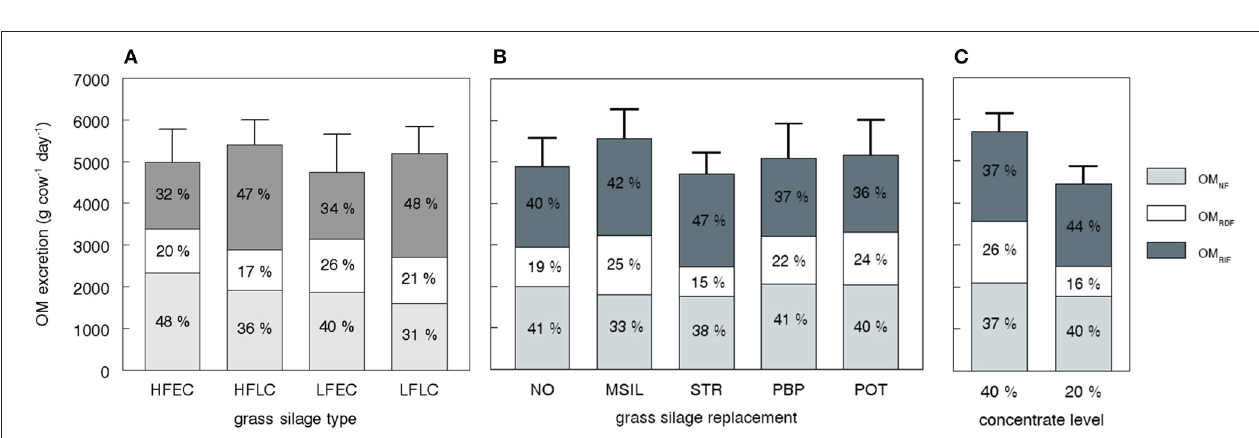
FIGURE 3 | Simulated organic matter (OM) excretion divided in three different fractions as affected by nutritional strategy. The excreta fractions represent OM NF (non-fibrous OM), OM RDF (rumen potentially digestible fiber), and OM RIF (rumen indigestible fiber) as described in Table 6 . The bars represent average values for all strategies with a given grass silage type ( A , n = 10), grass silage replacement ( B , n = 8) and concentrate level ( C , n = 20) as described in Table 3 . HFEC, high fertilized, early cutting stage grass silage; HFLC, high fertilized, late cutting stage grass silage; LFEC, low fertilized, early cutting stage grass silage; LFLC, low fertilized, late cutting stage grass silage; NO, no replacement of grass silage; MSIL, maize silage; STR, straw; PBP, pressed beet pulp; POT,